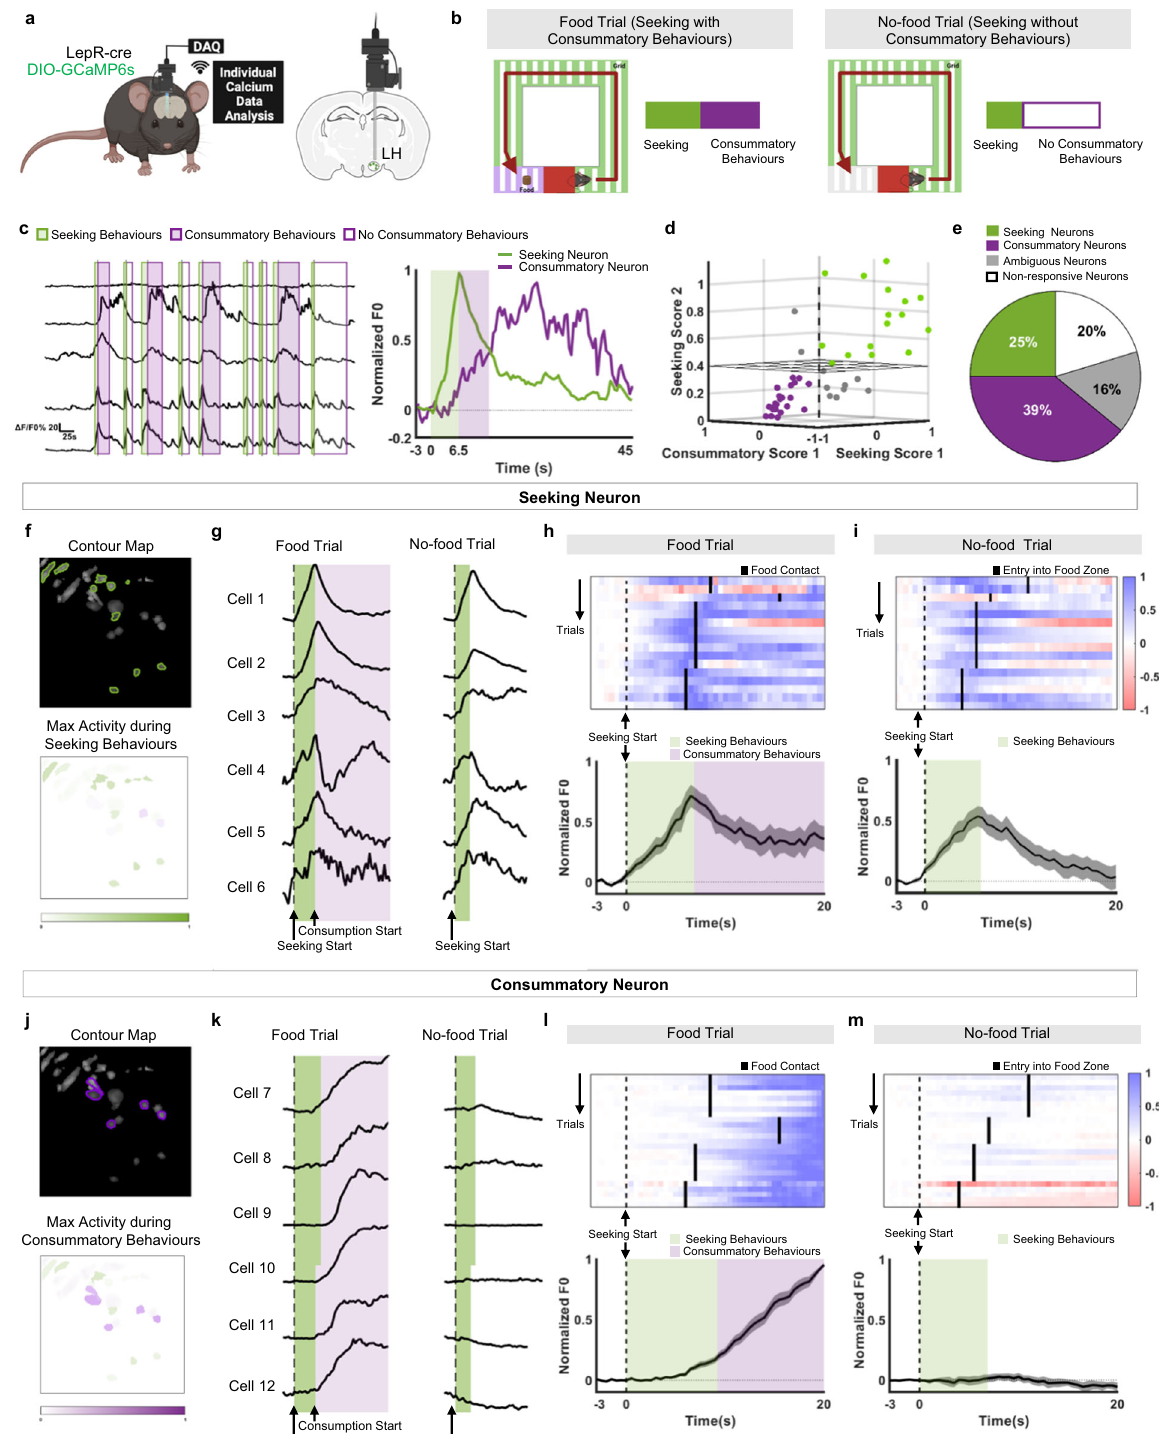
Fig. 3 | Two distinct populations of LH LepR neurons encode seeking and con- summatory behaviours. a Schematic of virus injection/GRIN lens insertion for micro-endoscopic calcium imaging in the LH from LepR-cre mice. b Schematic of the multi-phase test 2. Seeking with consummatory behaviours, in the presence of food (left). Seeking without consummatory behaviours, in the absence of food (right). c Representative single-cell traces of LH LepR neurons within several trials (left) and one trial (right). Green shaded box indicated seeking behaviours and purple shaded box indicated consummatory behaviours. d Three-dimensional scored plot of LH LepR neurons. e Proportion of cell populations. f , j Representative contour map of seeking ( f , green) and consummatory ( j , purple) neurons of an